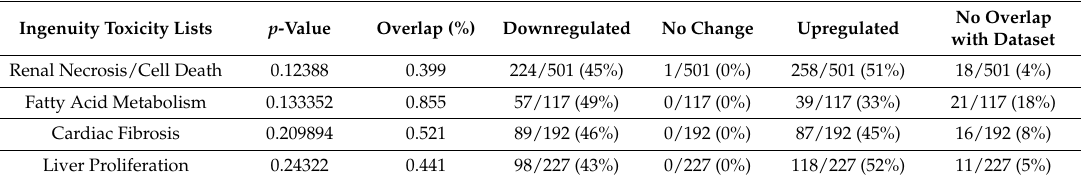
Table 6. Categories of biological functions with diseases or function annotation activated